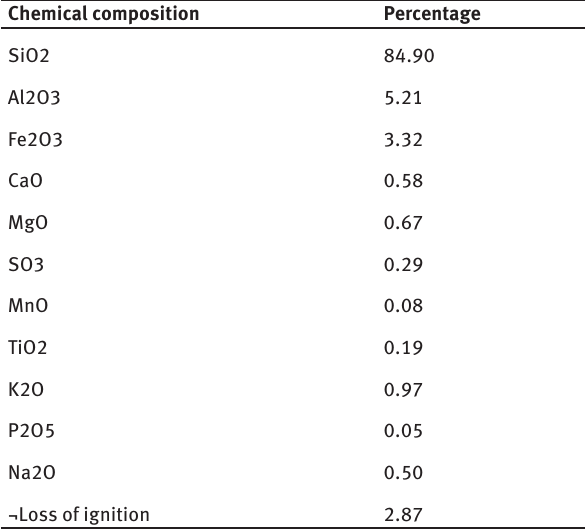
Table 6: Chemical properties of WFS. Chemical composition